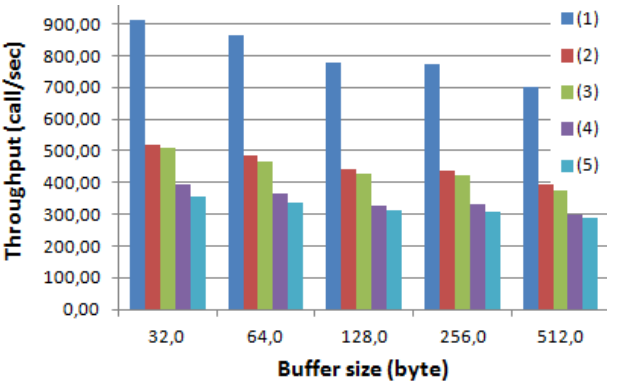
Figure 9. Middleware throughput average for various buffer sizes and security modes enabled.